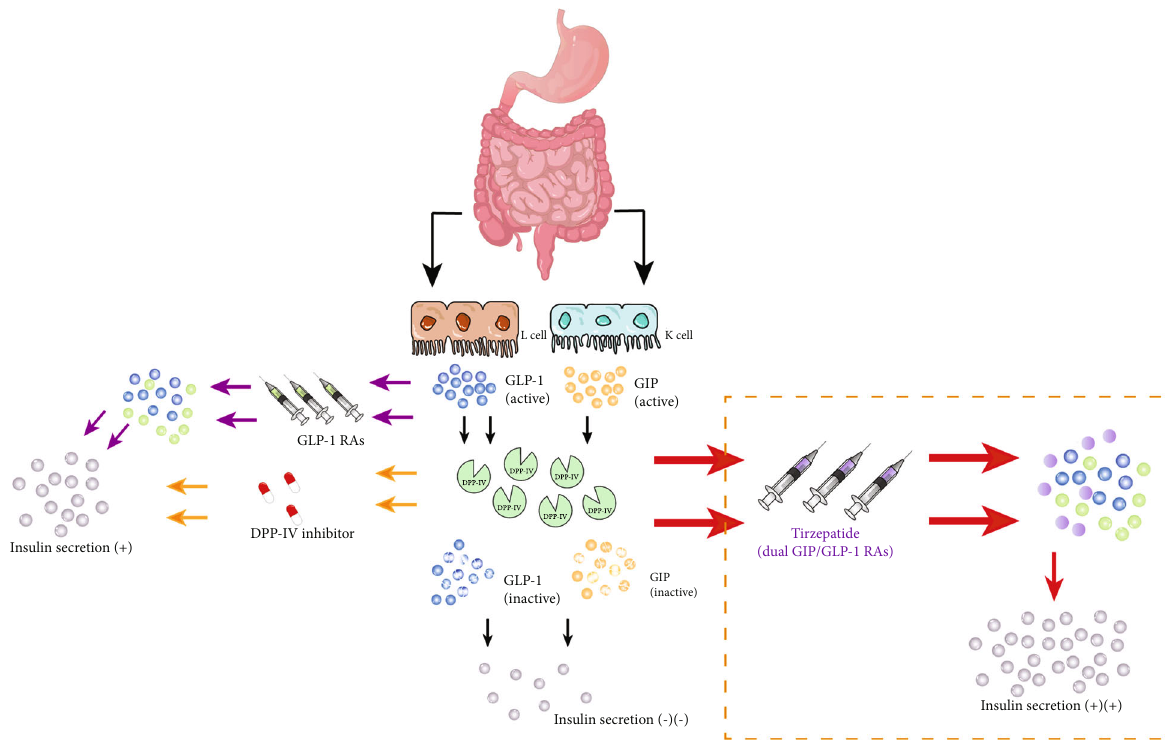
Figure 1: Drug mechanism of action of GLP-1 analogues, DPP-IV inhibitors, and GIP/GLP-1 receptor